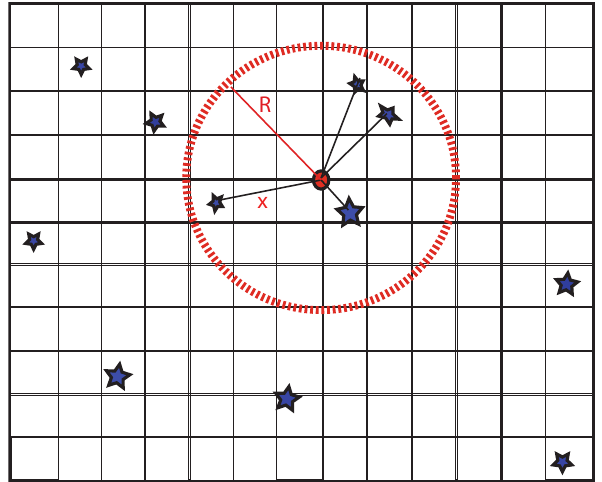
Fig. A5. Spatial gridding of centennial proxy anomalies on a 1 ◦ × 1 ◦ grid using a modified near-neighbour gridding algorithm. Capital R is the search radius from each grid node as computed by Eq. (A2) where lat is the latitude of the grid node. Lower case x is the great circle distance from the grid node to a proxy location. Provided there are 3 or more proxies within search distance R the grid node value is computed as the weighted average of the proxies centennial mean anomalies using weights defined by Eq.